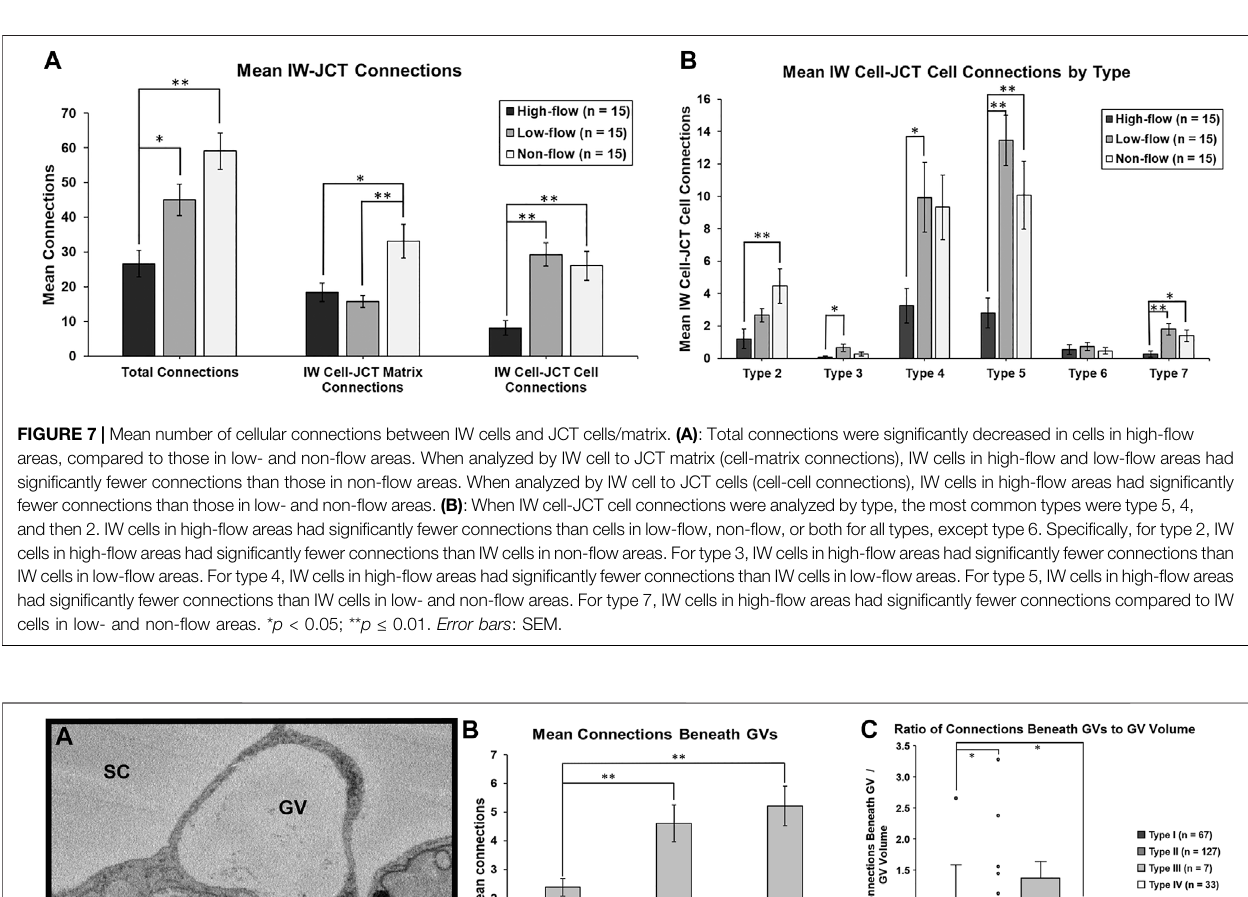
( Figure 7A ). IW cell-JCT matrix connections and IW cell-JCT cell connections were also signi fi cantly decreased in the cells in high- fl ow compared to those in low- and/or non- fl ow areas ( Figure 7A ). These results suggest that the physical separation between the JCT and IW observed in ex vivo perfused eyes may be due to decreased cellular connectivity between the IW cells and JCT cells/matrix.